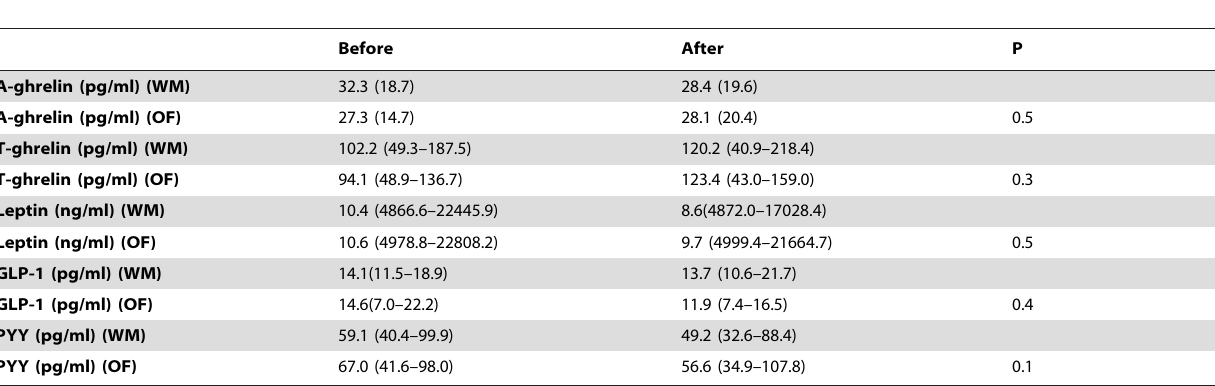
Table 3. Fasting Circulating Hormones Concentrations prior to and following each Diet.